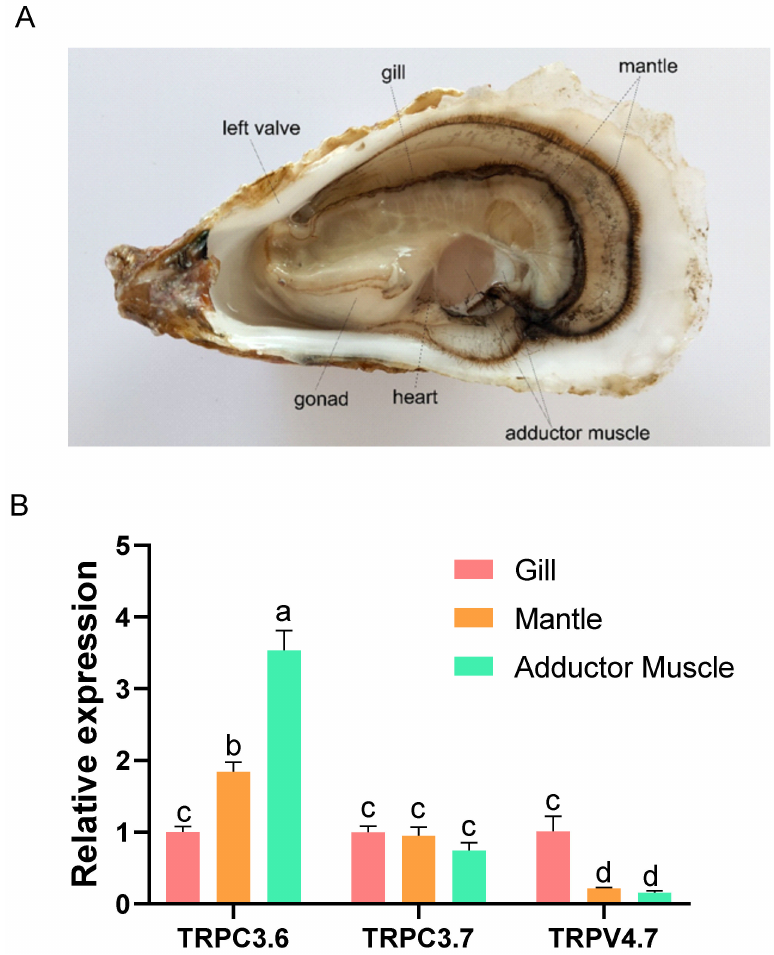
Figure 6. ( A ) The anatomy of the oyster; ( B ) Tissue distribution of selected TRP genes in oysters. The Y-axis represents relative expression as normalized expression levels of the elongation factor 1 alpha (EF1 α ) gene. Each value of relative expression was shown as mean ± S.E. ( n = 3). Values in bars that share the same superscript letter are not significantly different ( p > 0.05, Tukey’s